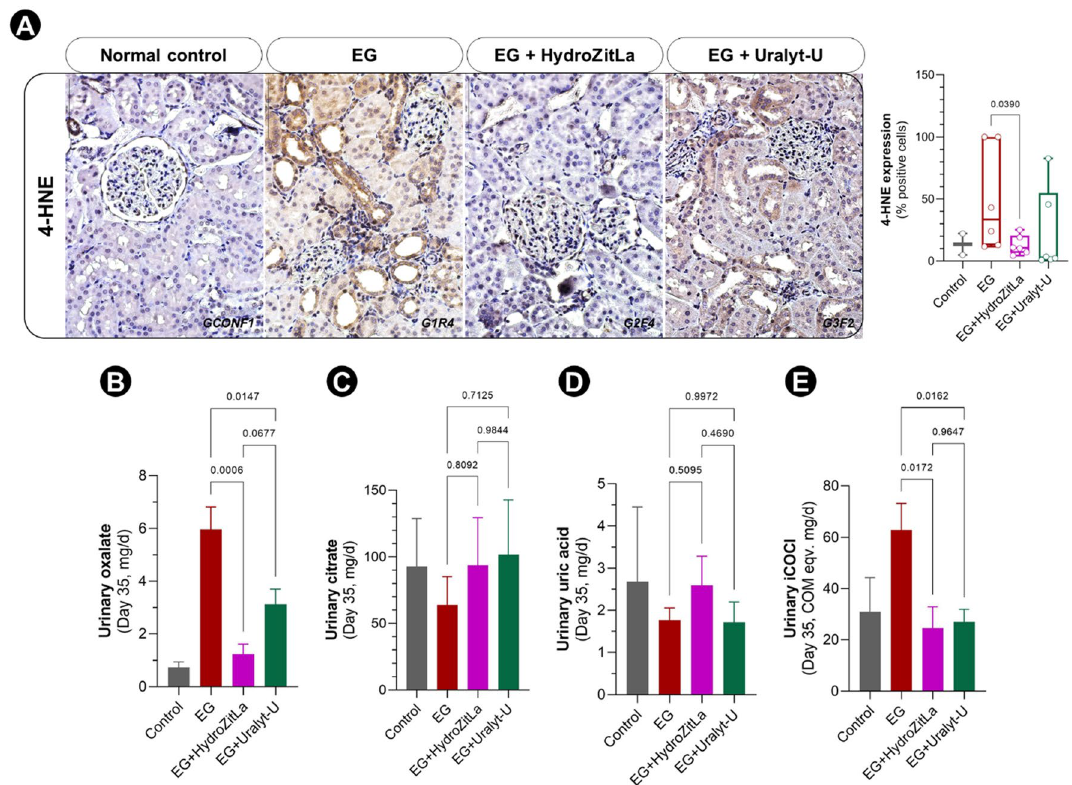
Figure 4. Expression of 4-HNE in rat renal sections and levels of oxalate, citrate, uric acid, and iCOCI in 24-h urine samples (day 35). ( A ) 4-HNE expression was obviously increased in EG rat renal tissues relative to normal control rat. Intrarenal expression of 4-HNE in EG + HydroZitLa rats was significantly lower than that in EG rats. ( B ) Urinary oxalate was elevated in EG rats relative to normal control rats. Levels of urinary oxalate in EG + HydroZitLa and EG + Uralyt-U rats were significantly lower than that in EG rats. ( C ) Urinary citrate was declined in EG rats relative to normal control rats. Levels of urinary citrate excretion in rats treated with HydroZitLa and Uralyt-U were higher than that in EG rats, and they could reach the normal levels found in normal control rats. ( D ) Urinary uric acid levels among EG, EG + HydroZitLa, and EG + Uralyt-U rats were comparable. ( E ) Similar to urinary oxalate, levels of urinary iCOCI of EG + HydroZitLa and EG + Uralyt-U rats were significantly lower than that of EG rats. Micrograph magnification: ×